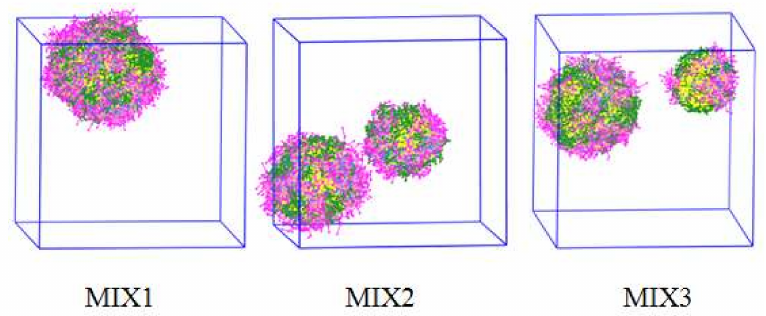
Figure 5. Morphologies of MIX1, MIX2, and MIX3 at 120,000 steps with 3% volume fraction of PDEAEMA-PPEGMA, 3% volume fraction of PCL-PPEGMA, and 3% volume fraction of